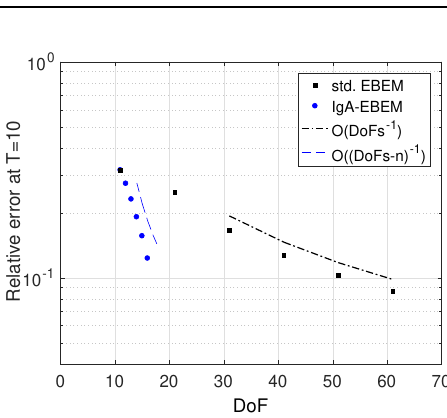
) ψ ∞ ( − · (cid:107) H − 1 2 ( Γ )